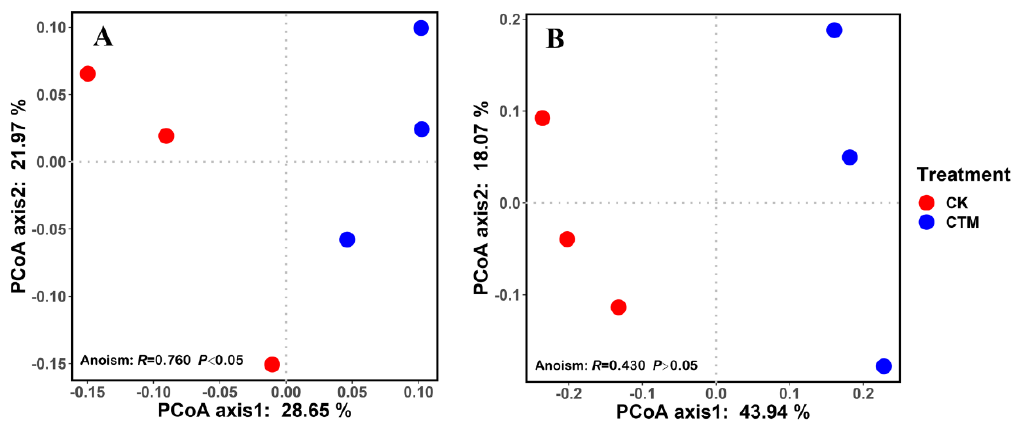
Figure 2. Principal coordinate analysis (PCoA) of the soil bacterial community ( A ) and fungal community ( B ) of an L. gmelinii plantation after crop tree management.